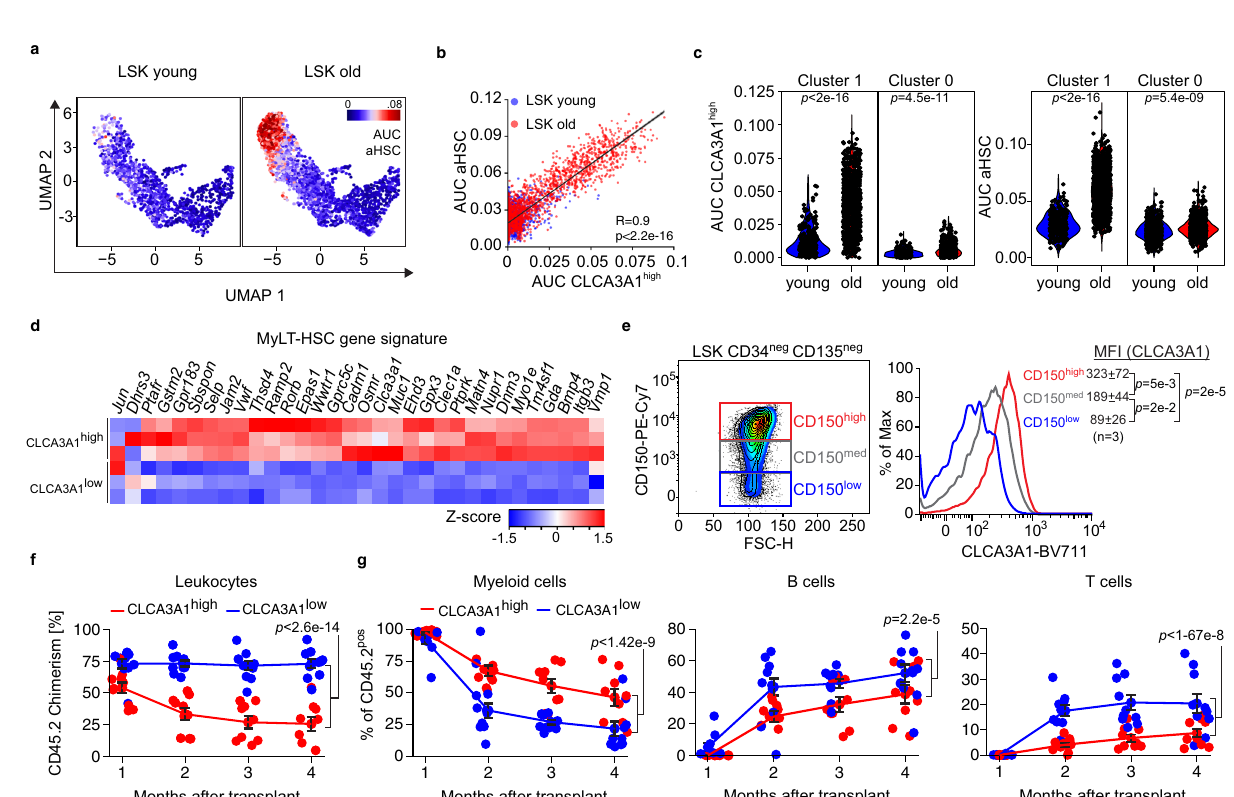
Fig. 2 | Clca3a1 is induced by TAZ and marks oLT-HSCs. a Overlap among upregulated genes of the indicated RNA-Seq datasets (Log 2 FC>0.5, FDR<0.01). b Top TAZ-induced LT-HSC-speci fi c genes sorted according to their regulation in old vs. young LT-HSCs. c RPKM values (Log 2 scale) of Wwtr1 , the TAZ target gene Amotl2 and Clca3a1 determined by RNA-Seq ( n =3 per age group and population). d Representative fl ow cytometry plots for CLCA31 expression in the given popu- lations from young and old mice. e Quanti fi cation of samples analyzed in d ( n =25 for young, n =29 for old mice). f Single cell colony-forming assay of isolated CLCA3A1 low and CLCA3A1 high LT-HSCs. Single cells were seeded and the time to completionofthe fi rstcelldivisionwasmeasured( n =3pergroup,one-wayANOVA with Tukey HSD post hoc test). g Left panel: MA plot of an RNA-Seq comparing CLCA3A1 high vs. CLCA3A1 low LT-HSCs ( n =3 per group, LSK CD34 neg CD135 neg ). Sig- ni fi cantly up- and downregulated genes (FDR<0.01) are colored in red and blue, respectively. Right panel: Signi fi cantly regulated genes of the CLCA3A1 high vs. CLCA3A1 low RNA-Seq were colored in the RNA-Seq comparing old vs. young LT- HSCs. Boxplot: bottom/top of box: 25th/75th percentile; upper whisker: